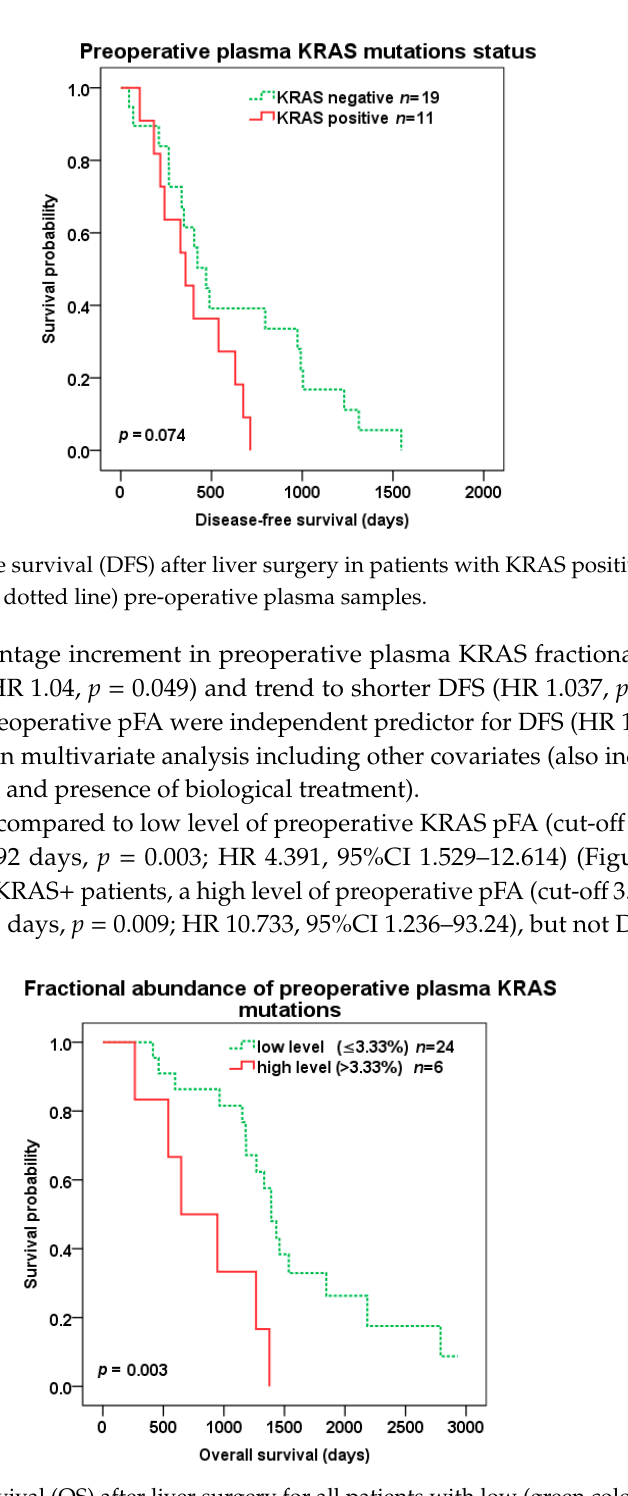
Figure 4. Overall survival (OS) after liver surgery for all patients with low (green color dotted line) vs. high (red color) KRAS fractional abundance in pre-operative plasma samples (cut-off 3.33%).